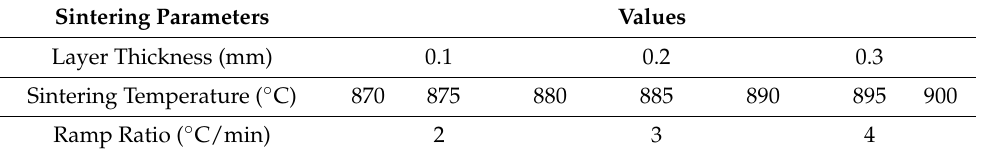
Table 2. Parameters of the sintering process.